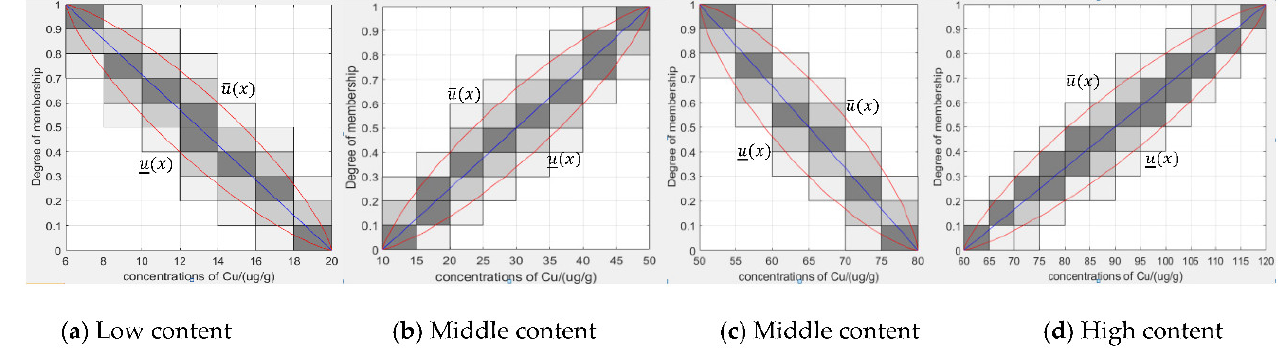
Figure 4. The granular type-2 fuzzy membership function for copper.